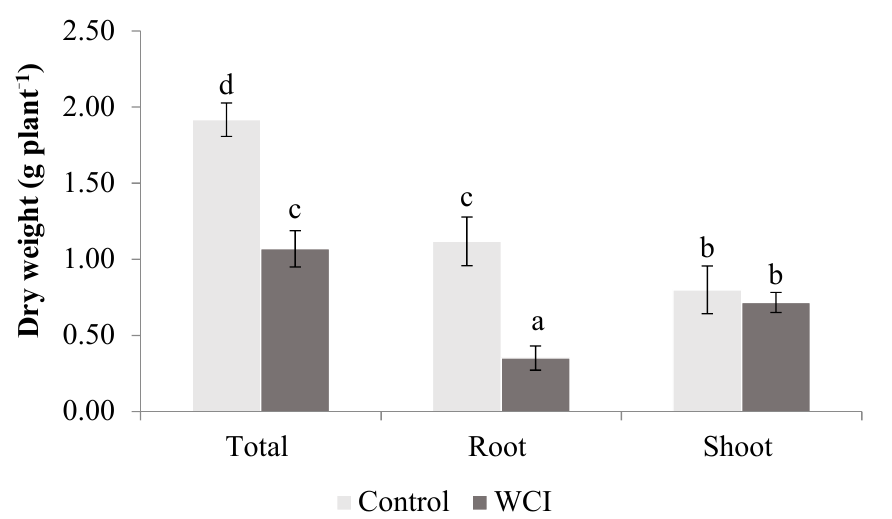
Figure 4. The effect of woolly cupgrass infestation (WCI) on the dry weights of maize 21 d.a.s. (values represent means ± SD, n = 5). Small letters (a, b, c, d) show significant differences between treatments based on independent t -test ( p < 0.05).